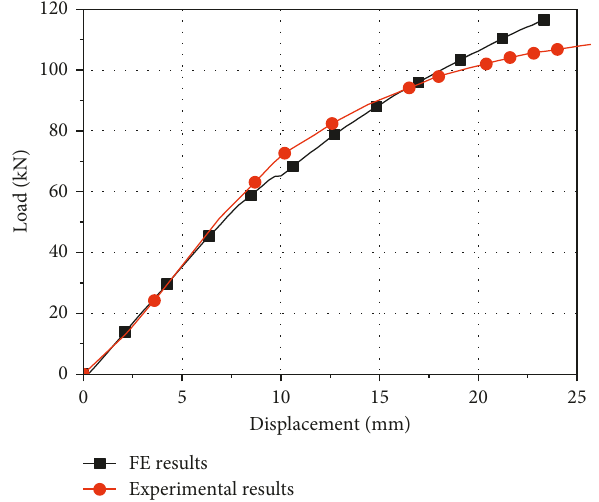
Figure 12: Comparison of the experimental and numerical load- displacement curves of specimen TS75-100.